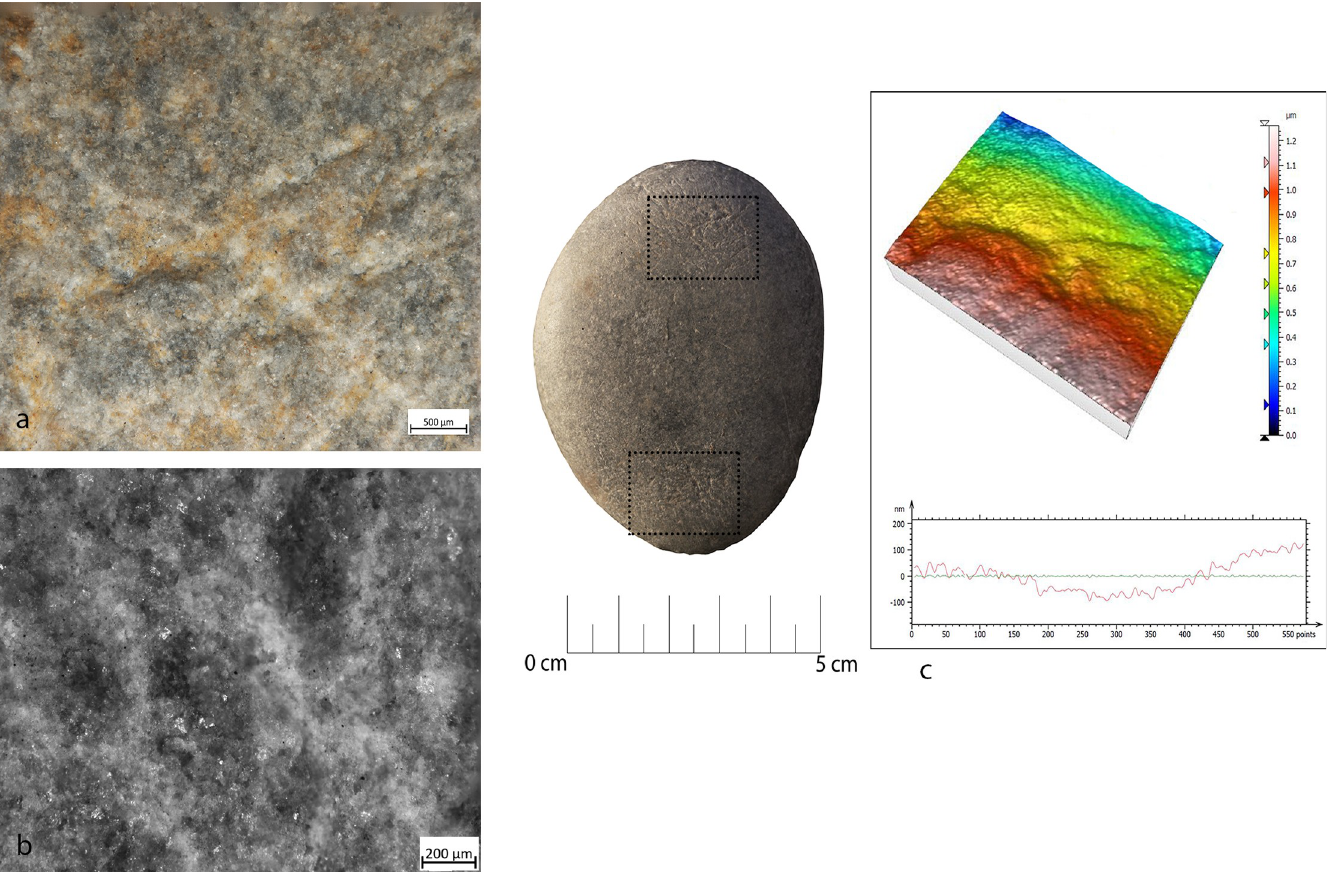
Fig 24. Use wear identified on artefact RF127. (a) Macro-traces (30x), contiguous pits of linear form (half-moon), with rough bottom, located on the centre of apical area; (b) pits with rough bottom (200x); (c) 3D microtopography of the used